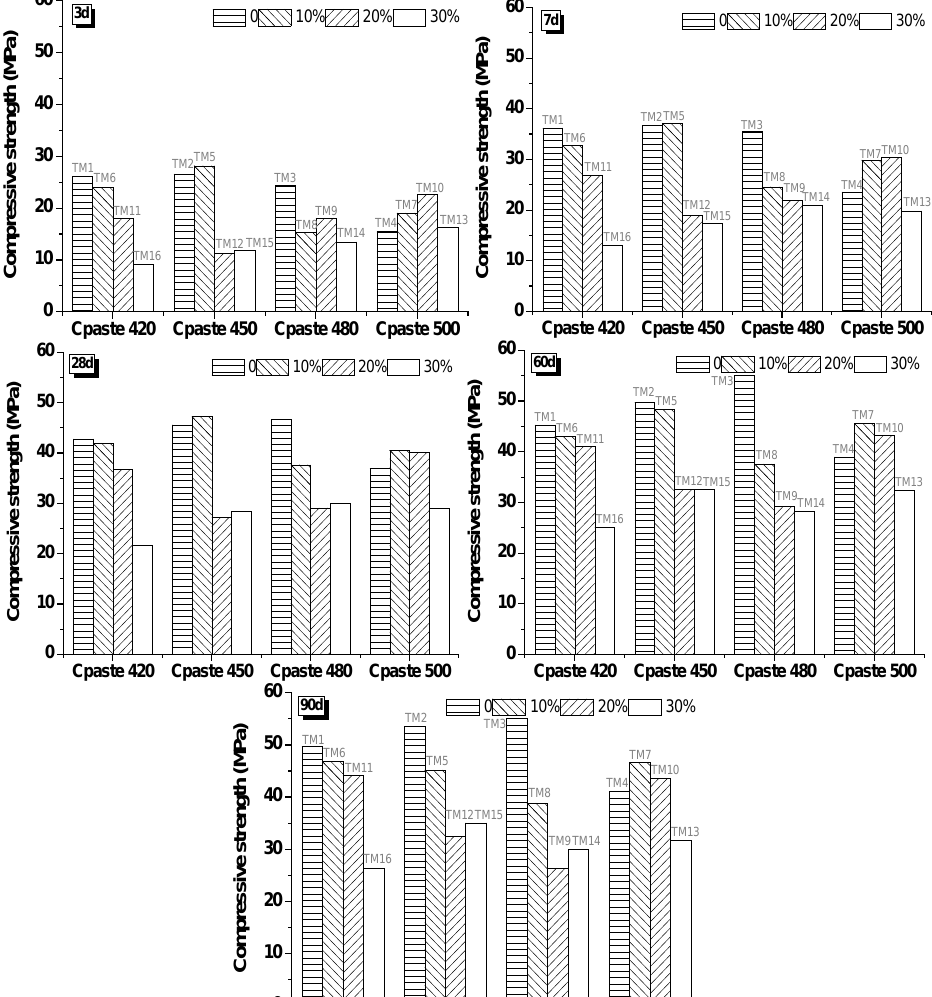
Figure 6. The relationship of substitution rate, curing age, and C paste .